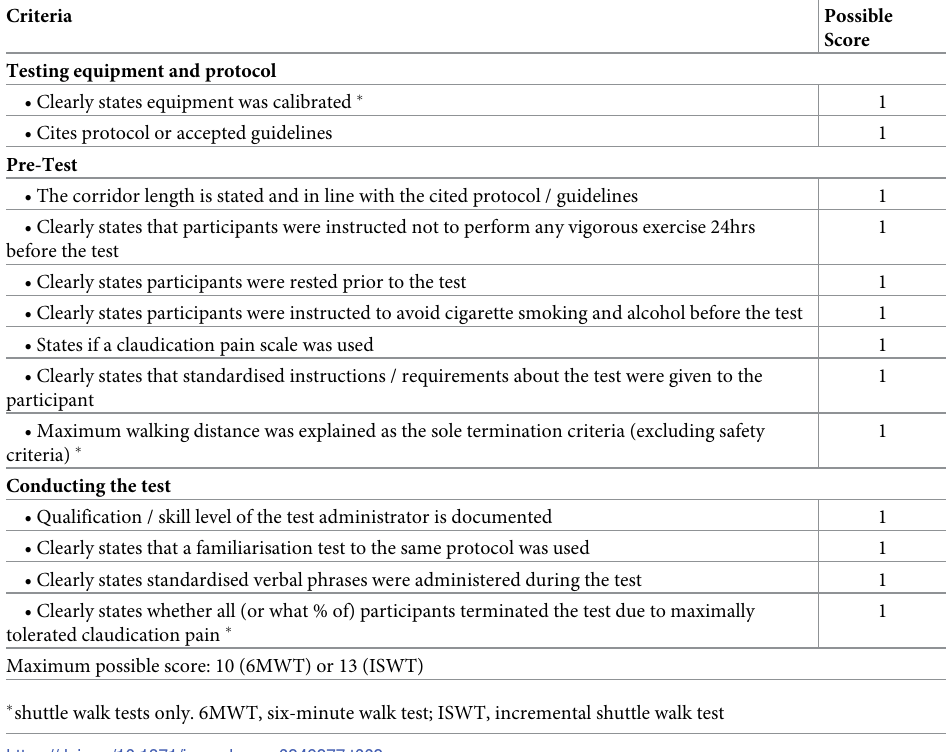
Table 2. Corridor walk testing criteria (6MWT and ISWT).